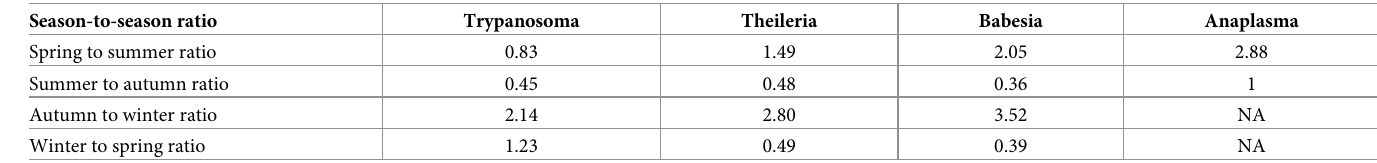
Table 3. Season-to-season ratio as a measure of seasonality of the infection percentage according to the type of blood parasite. Season-to-season ratio Trypanosoma Theileria Babesia Anaplasma Spring to summer ratio 0.83 1.49 Summer to autumn ratio 0.45 Autumn to winter ratio Winter to spring